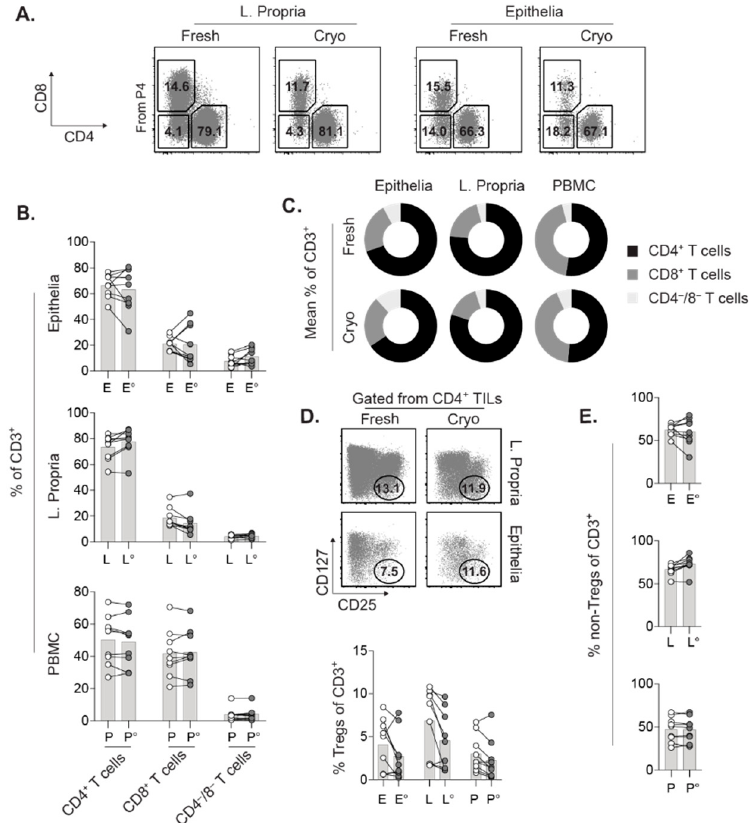
Figure 2. Determination of T cell subset frequencies within total CD3+ T cells. ( A ) Gating of T cell subsets from total CD3+ T cells ( P4 in Figure 1B), which contain the CD4+ TILs, CD8+ CTLs, and CD4– CD8– population. Percentages of parent population shown. ( B ) Compiled data on T cell subset frequencies within total CD3+ T cells. ( C ) Proportions of CD4+ TILs, CD8+ CTLs, and CD4– CD8– TILs in tumor compartments and their counterparts in PBMCs. ( D ) Gating of CD4+CD25+CD127dim/–Tregs and their frequency among total TILs or T cells in PBMCs. Percentages of parent population shown. ( E ) Frequency of non-Tregs (i.e., CD4+ T cells outside the Treg gate) in total TILs or circulating PBMCs. E, L, and P denotes epithelia, lamina propria, and PBMC, respectively. ◦ indicates cryopreserved samples. Bars show the mean. Welch’s t